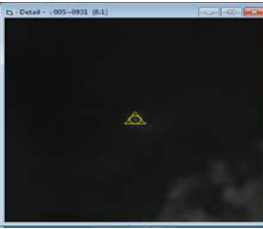
Figure 2 manual point measurement in shadow